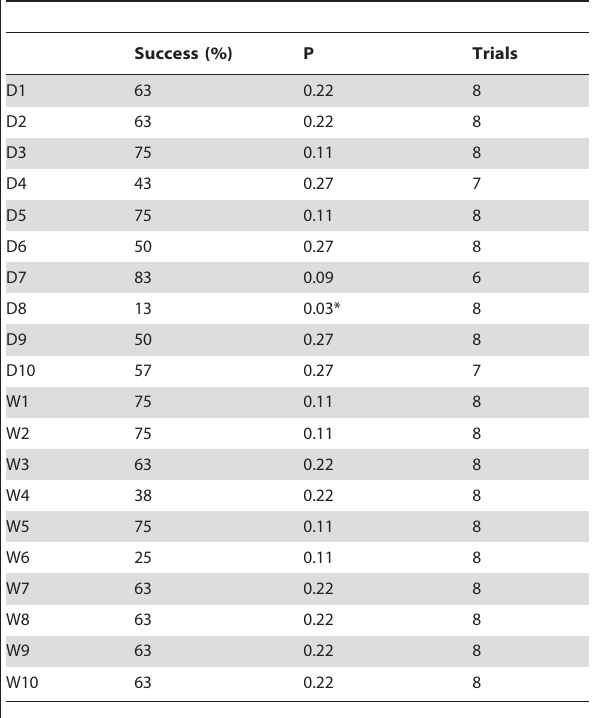
Table 1. Learning performances in domesticated and wild